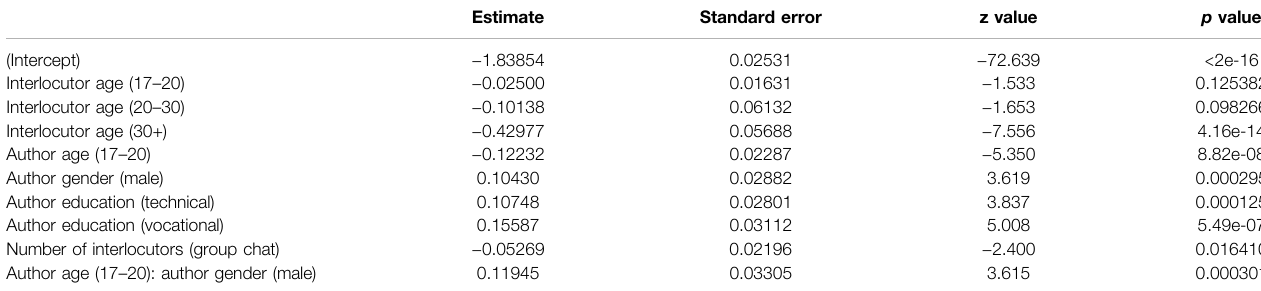
TABLE 6 | Orality per interlocutor age: Fixed effects 11